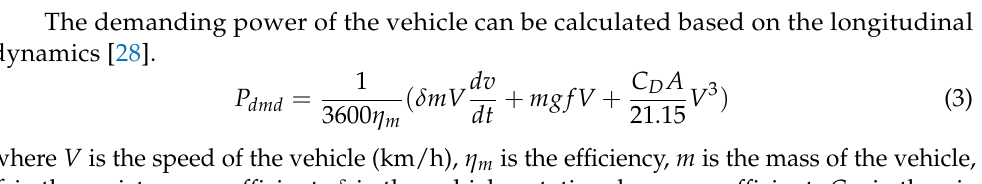
Figure 8. Prediction results.